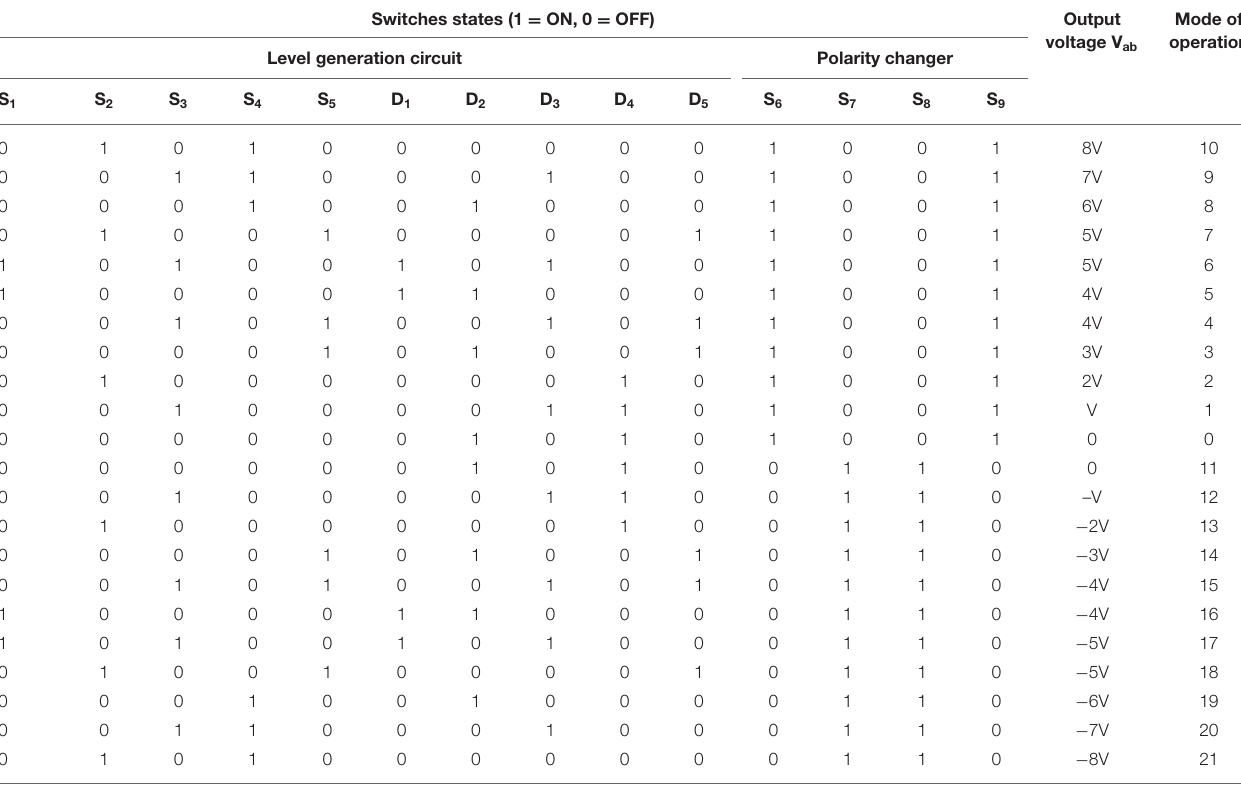
TABLE 1 | All switching states of the proposed seventeen level inverter. Switches states (1 = ON, 0 = OFF) Output